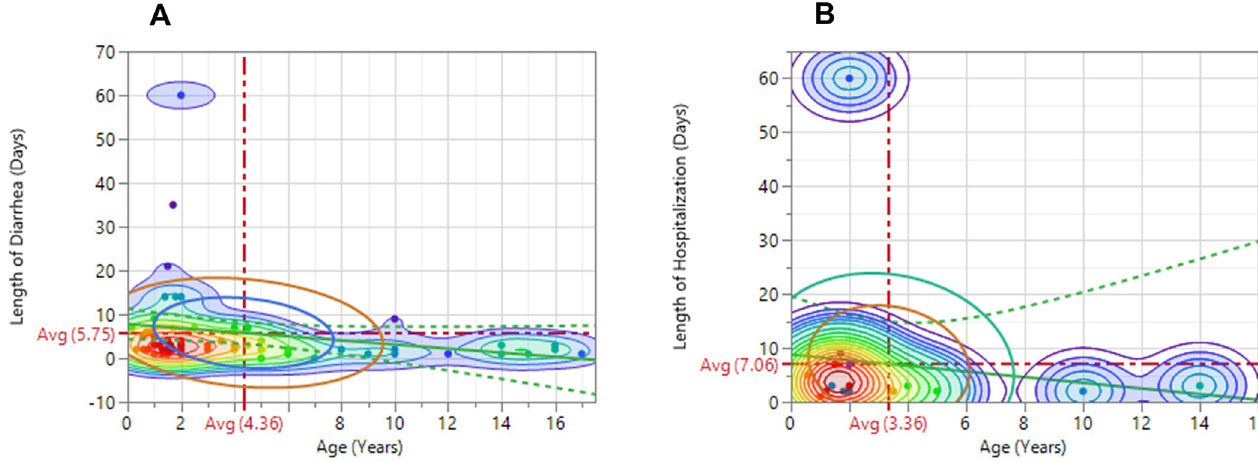
Fig 2. Relationship between the length of diarrhea and hospitalization (A) and age of pediatric patients (B).